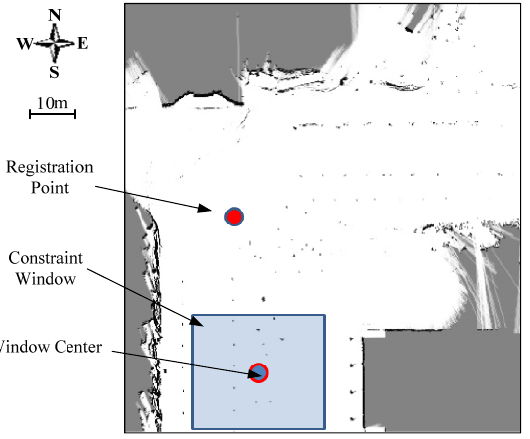
Figure 6. Constraint window in the grid map of the loose constraint (LC)